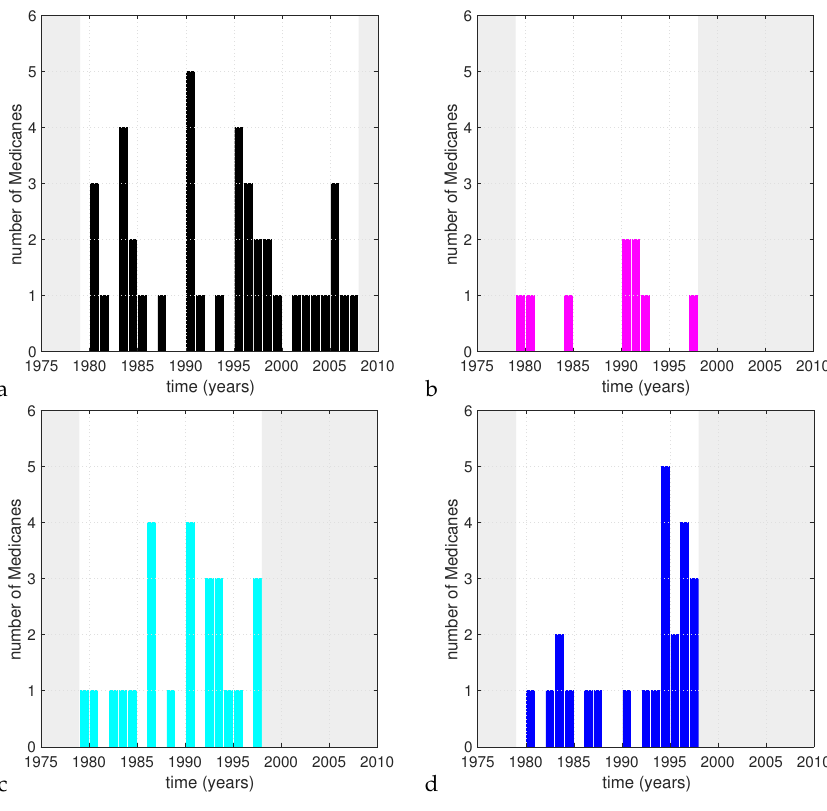
Figure 4. Time series of the number of detected Medicanes per Medicane season for G = 3.21 × 10 − 2 hPa km − 1 in the et04 ( a ), bt11 ( b ), kt11 ( c ) and kw11 ( d ) simulations. The shaded areas indicate time periods outside the range of the